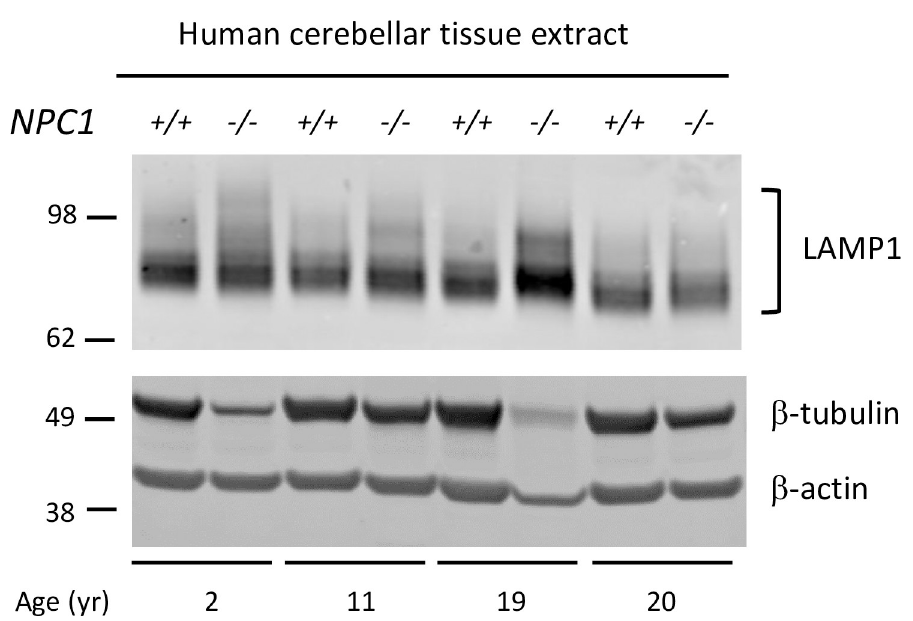
Fig 9. Hyperglycosylated LAMP1 is present in NPC1 postmortem CNS tissue. Western blot of human cerebellar tissue extracts from NPC1 (-/-) and age-matched controls (+/+). The Western blot shows LAMP1 with β -tubulin and β -actin as loading